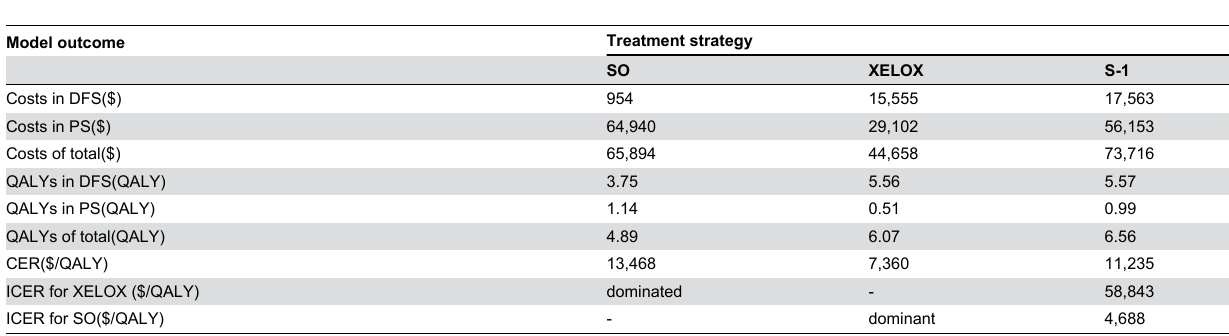
Table 5. The base-case results for three